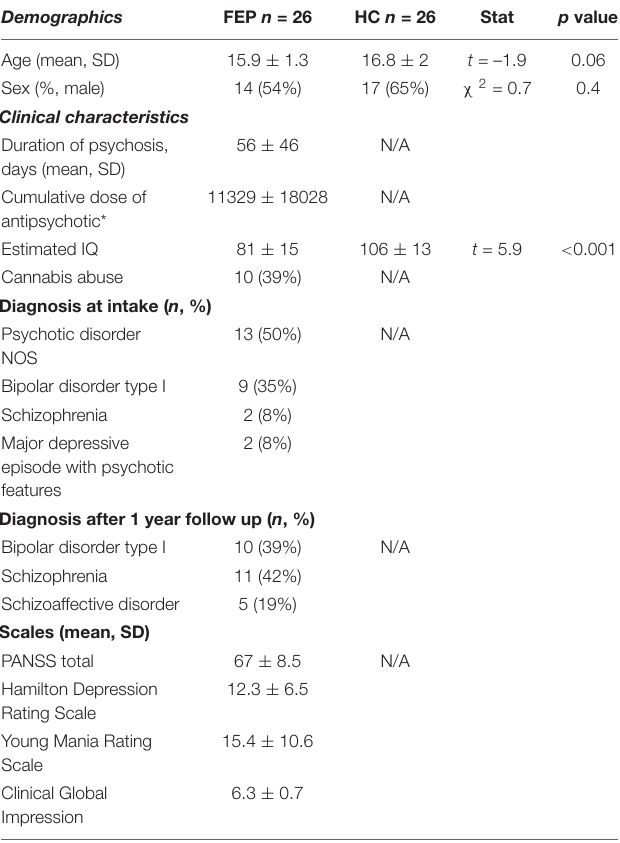
TABLE 1 | Demographics and clinical characteristics of the